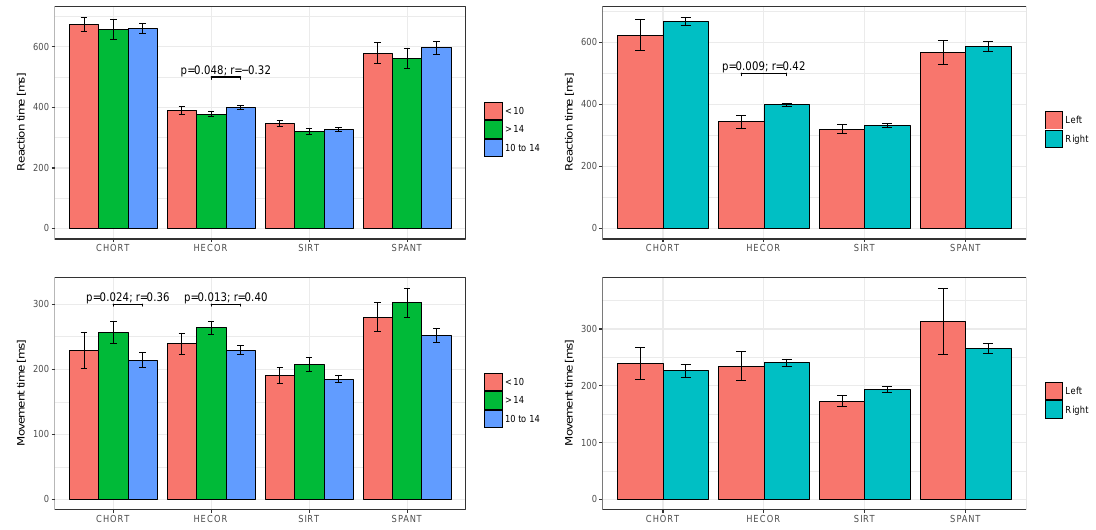
Figure 3. Player’s training seniority; <10—less than 10 years, 10 to 14—seniority from 10 to 14 years, >14—over 14 years; Dominant hand; Left—dominant left hand, Right—dominant right